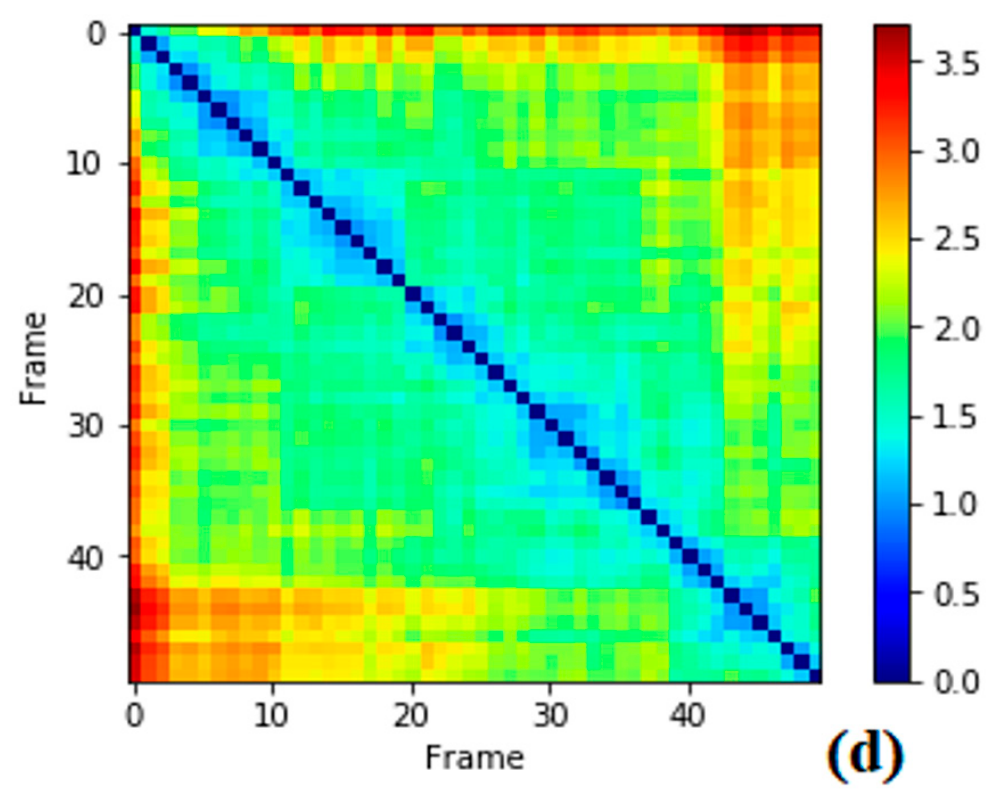
Figure 2. Root mean square deviation (RMSD) evolutions from molecular dynamics (MD) simulations of ( a ) BACE1 (green) and Inhibitor 68J (black) in 5i3X; ( b ) 5i3W BACE1 (green) and 68L inhibitor (black); ( c ) 5i3V, the BACE1-68M complex ( d ): pairwise plot of RMSD of BACE1-68J complex in 5i3X, RMSD pairwise computed for first 5000 snapshots and skipped every 10 frames.